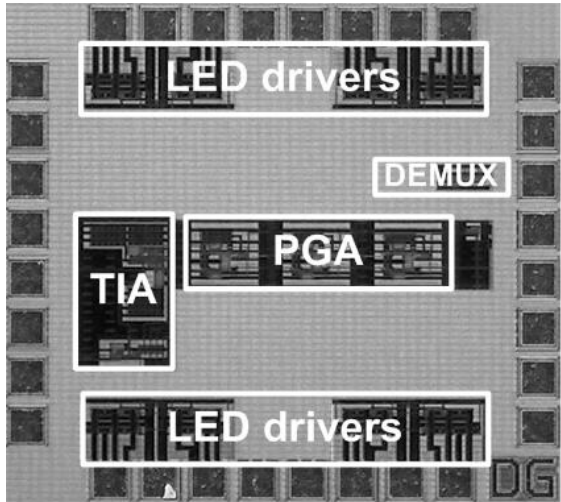
Figure 15. Die photo.